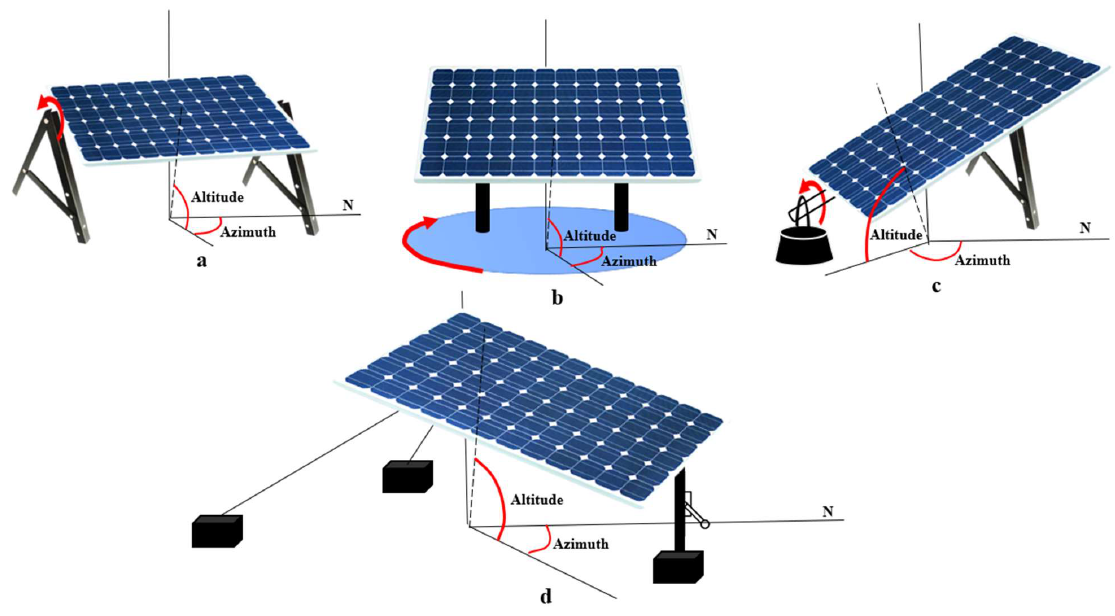
Figure 3. Various Single-axis Solar Tracking Systems. ( a ) HSAT; ( b ) VSAT; ( c ) PASAT; ( d ) TSAT. HSAT rotates from north to south on a fixed axis parallel to the ground, as shown in